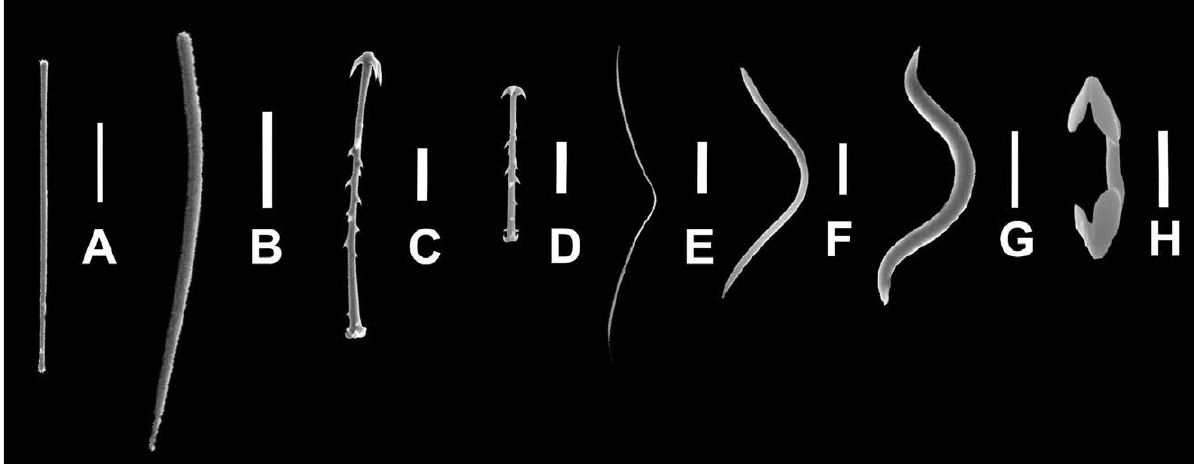
Fig . 7. – Acarnus sabulum n. sp. A, Ectosomal tylote with microspined heads. B, Choanosomal style. C, Cladoylote I microspined with four clades. D, Cladotylote II microspined with four clades. E, Accolada toxa. F, Wing-shaped toxa. G, Oxhorn toxa. H, Palmate isochela.